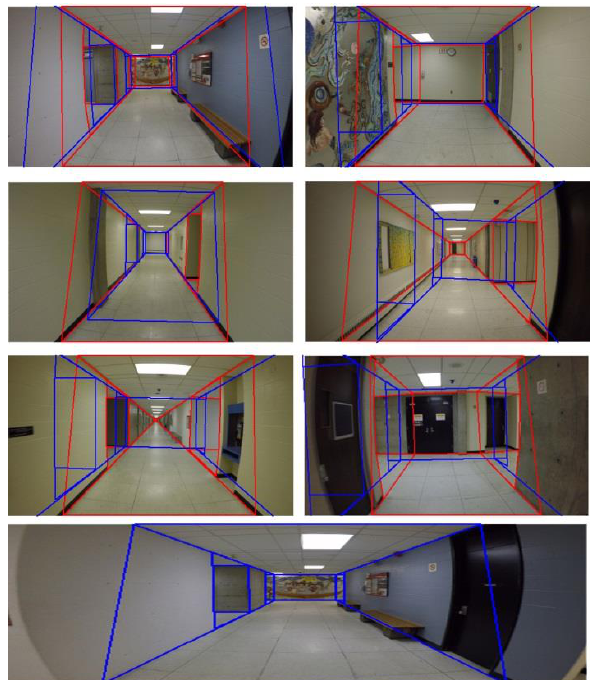
Figure 5. Test frame layout (bottom image) and keyframe layout (top images) matching. Here, layouts are projected on original (distorted)